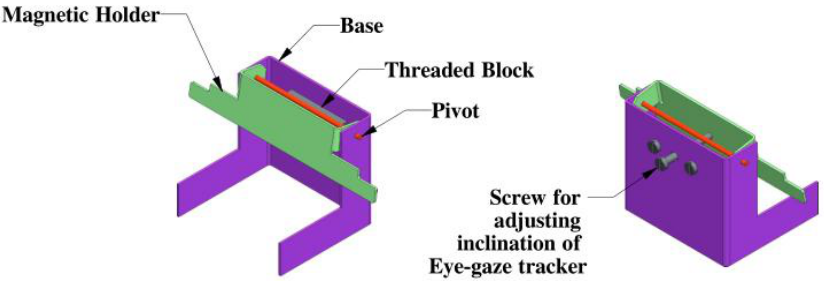
Figure 3. Components of tilting mechanism.